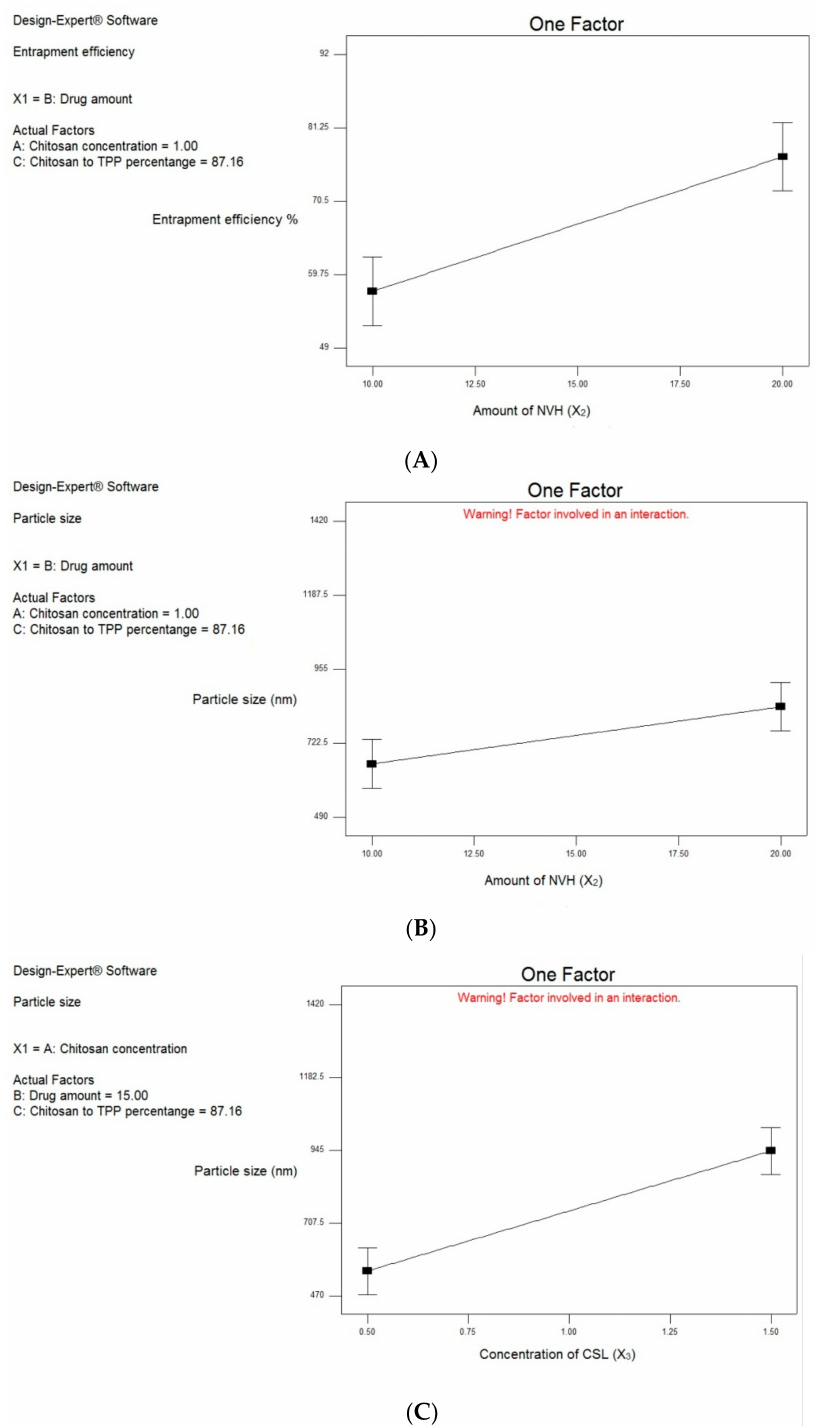
Figure 1. Line chart showing the effect of: ( A ) the amount of NVH (X 2 ) on the EE% of NVH in NVH-loaded chitosomal formulations; ( B ) the amount of NVH (X 2 ) on the PS of NVH in NVH- loaded chitosomal formulations; ( C ) the concentration of CSL (X 3 ) on the PS of NVH in NVH-loaded chitosomal